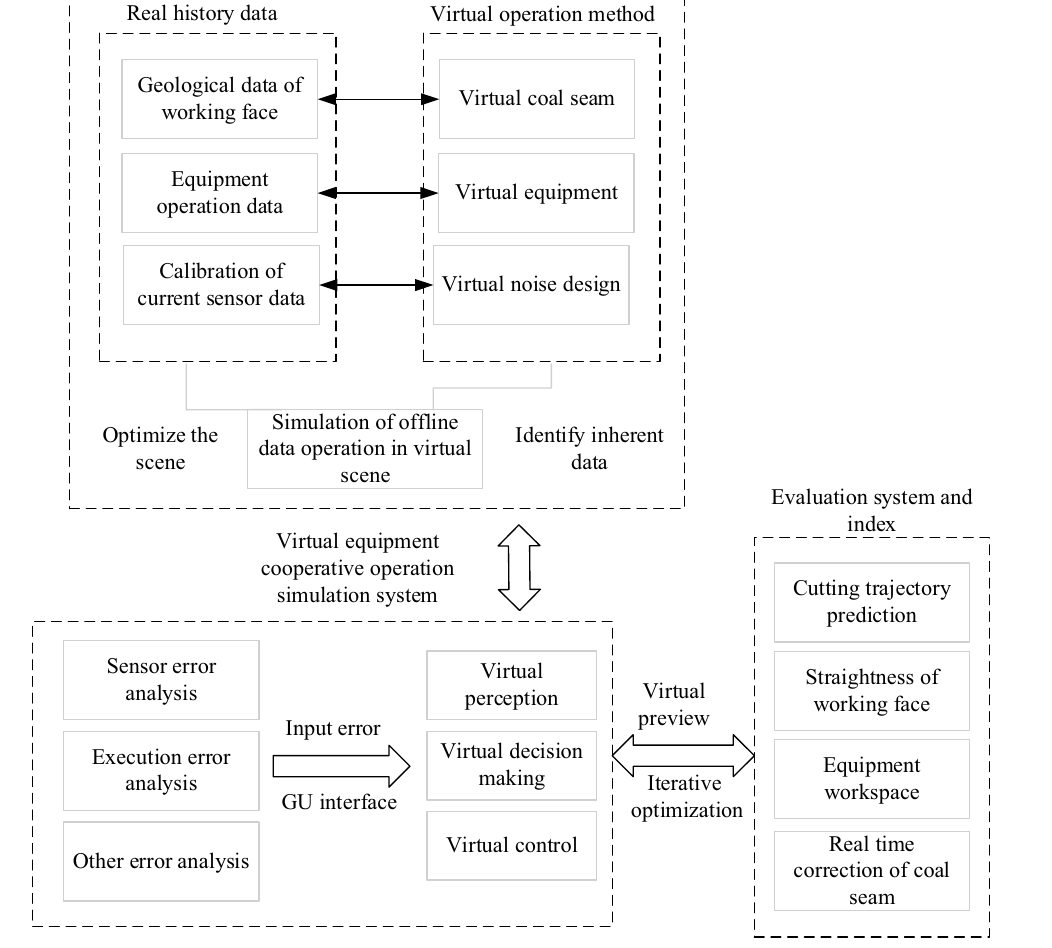
Fig. 1 Overall framework of the test and evaluation method